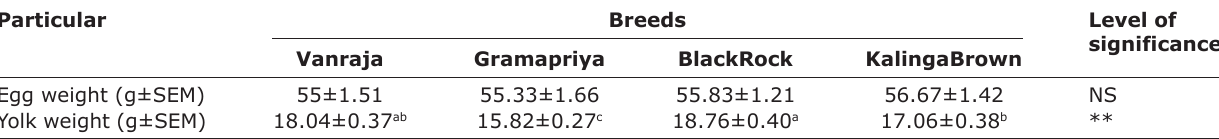
Table-1: Egg weight and yolk weight of four different breeds of poultry. Particular